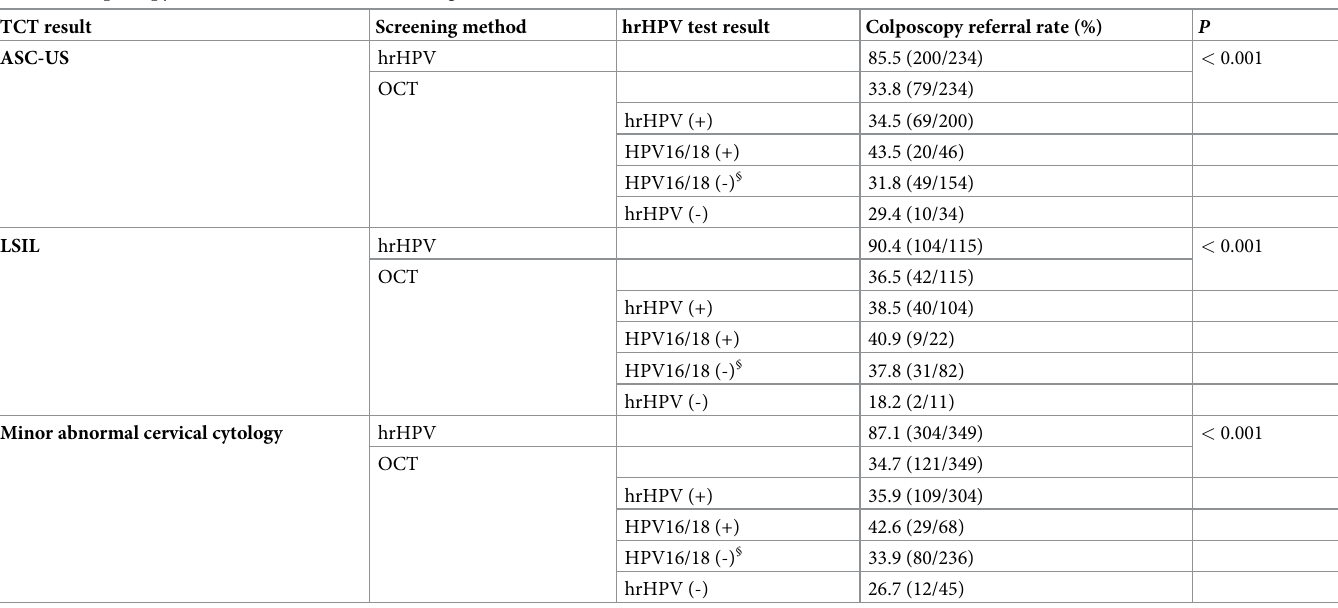
Table 5. Colposcopy referral rate of different screening methods.